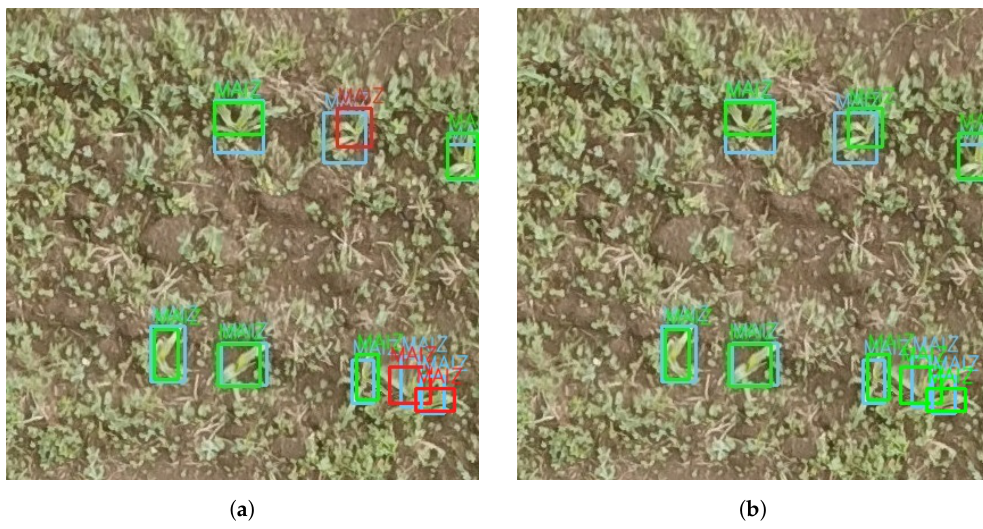
Figure 10. YOLOv5-l architecture detections for a confidence of 0.3 with an IoU threshold of 0.5 ( a ) and 0.25 ( b ). The blue boxes represent the ground truth label, green ones TP and red ones FP.